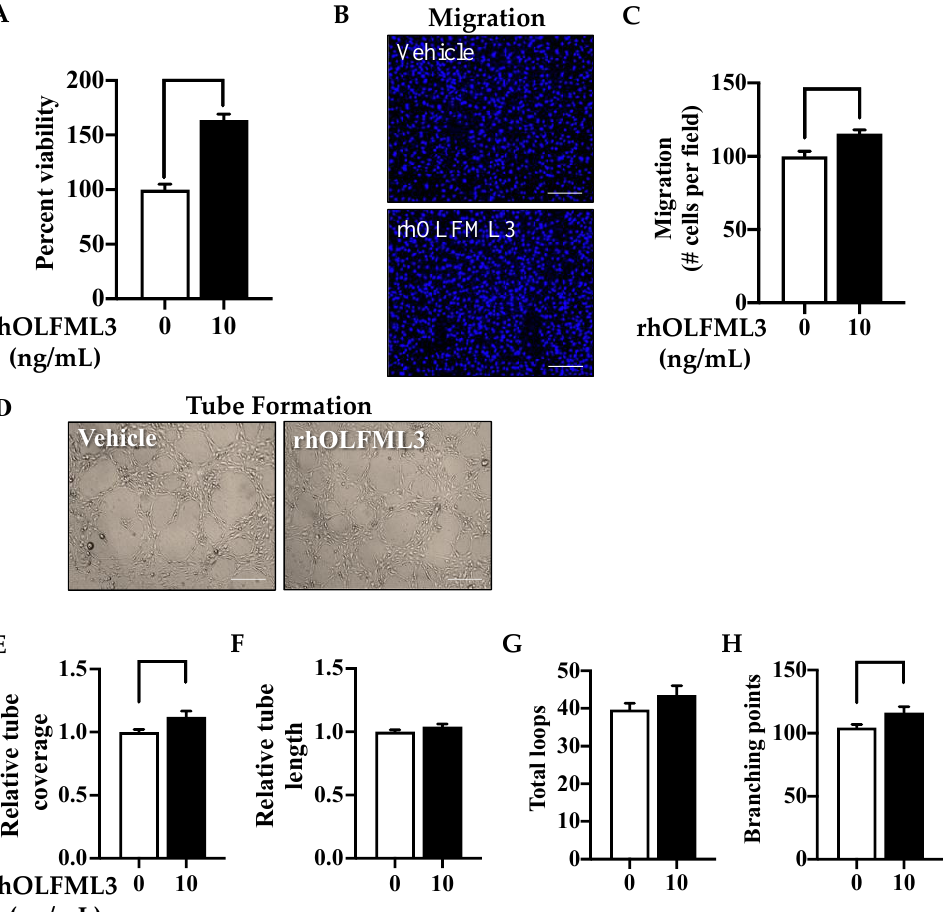
Figure 2. OLFML3 is sufficient to induce primary mouse brain EC angiogenesis. ( A ) Exposure to recombinant human OLFML3 (rhOLFML3; 10 ng/mL, 48 h) increased mouse brain endothelial cell (EC) viability relative to vehicle-treated cells. ( B ) Representative images of primary mouse brain EC migration following exposure to vehicle and rhOLFML3 (10 ng/mL; 48 h); scale bars 50 µm. ( C ) EC migration was increased following exposure to rhOLFML3 (10 ng/mL, 48 h). ( D ) Representative images of primary mouse brain EC differentiation following exposure to vehicle and rhOLFML3 (10 ng/mL; 48 h); scale bars 50 µm. Exposure to rhOLFML3 (10 ng/mL, 48 h) increased EC ( E ) tube coverage and ( H ) branching points relative to vehicle-treated cells. Comparisons based on unpaired student’s t test; bars represent group mean with standard error of the mean (SEM).